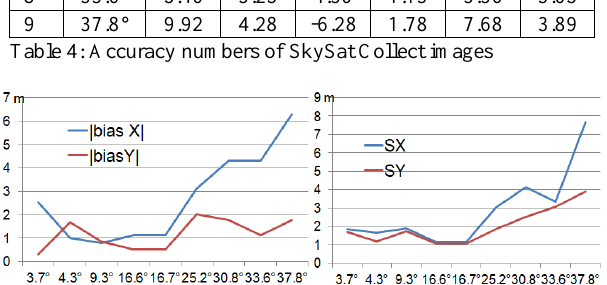
Figure 14: Absolute value of bias and standard deviation of SkySat Collect geo-reference as function of angle of incidence